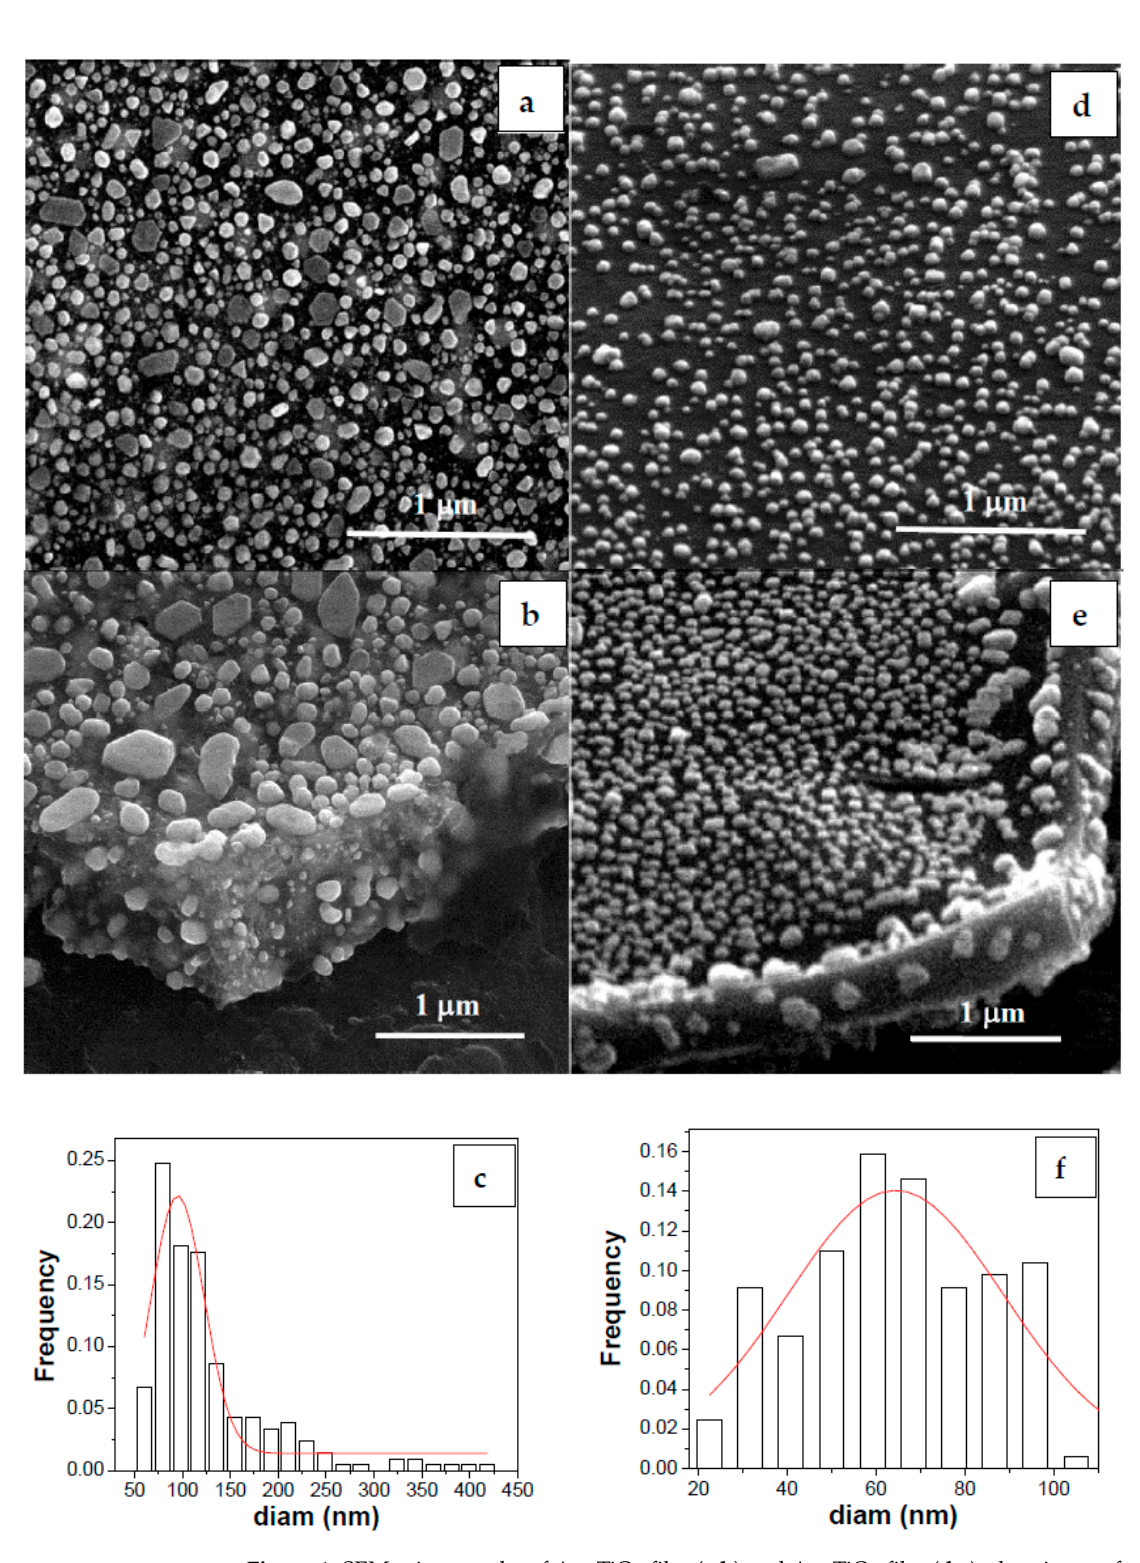
Figure 1. SEM micrographs of Au–TiO 2 film ( a , b ) and Ag–TiO 2 film ( d , e ), showing surface Au top view ( a ) and Ag tilted view ( d ) together with cross-section edge views ( b , e ) of the films. The particle size distribution for Au is presented in ( c ) while the Ag NPs histogram distribution is shown in ( f ). Chemical elemental analysis by EDS (Figure 2) confirmed the presence of Au and Ag particles decorating the titania films. Taking into account the atomic weights of Ag, Au, O, and Ti, the EDS-calculated Ag/TiO 2 volume ratio was found to be ~30 +/ −